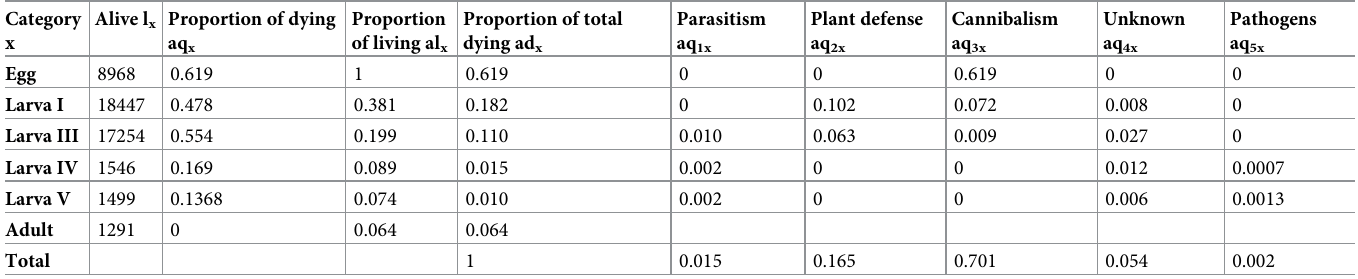
Larva I: Pre-parasitism period; Larva III: Parasitism period; Larva IV: Overwintered larva (pre-flight period; post-parasitism); Larva V: Overwintered larva (post-flight period; post